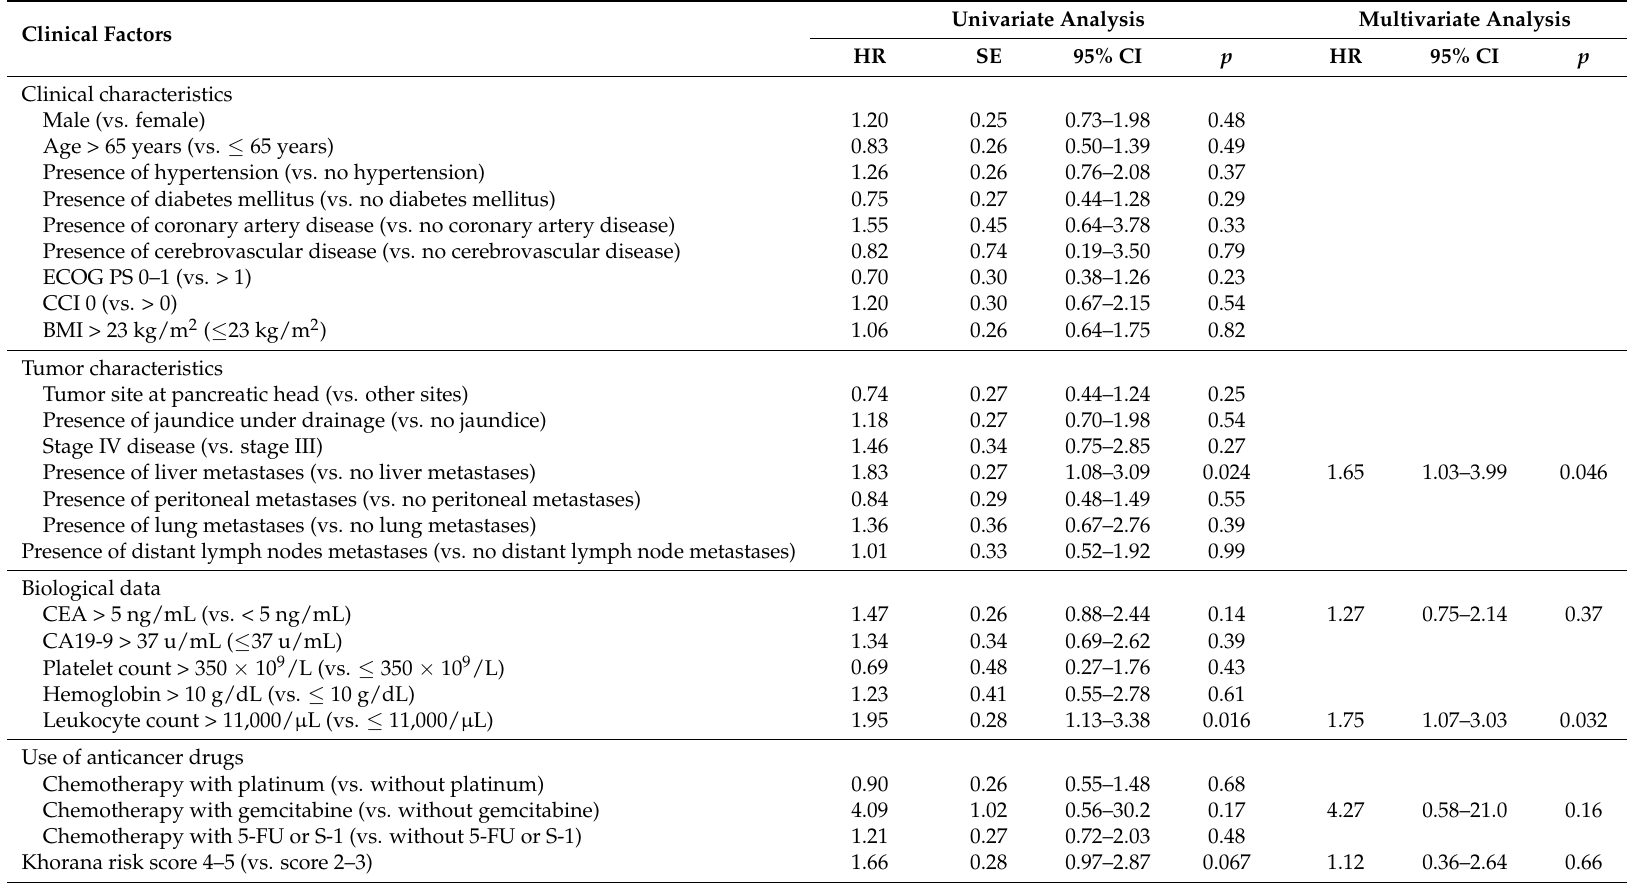
Table 3. Univariate and multivariate analyses of clinical factors for predicting venous thromboembolism occurrence. Clinical